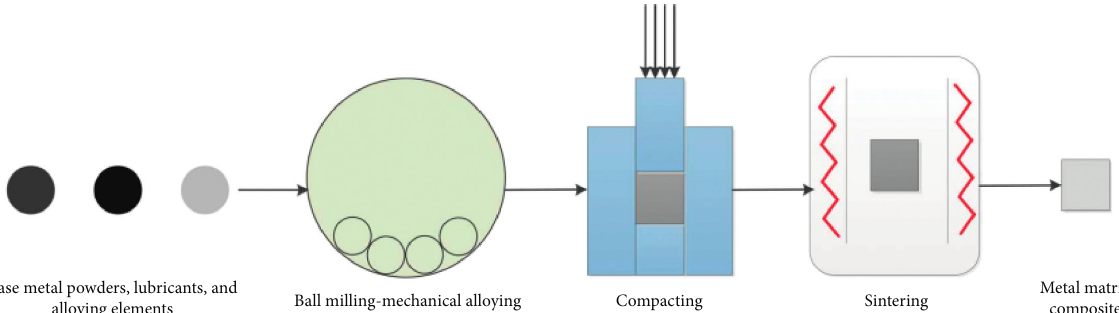
Figure 3: A Schematic illustration of the powder metallurgy technique to prepare MMCs